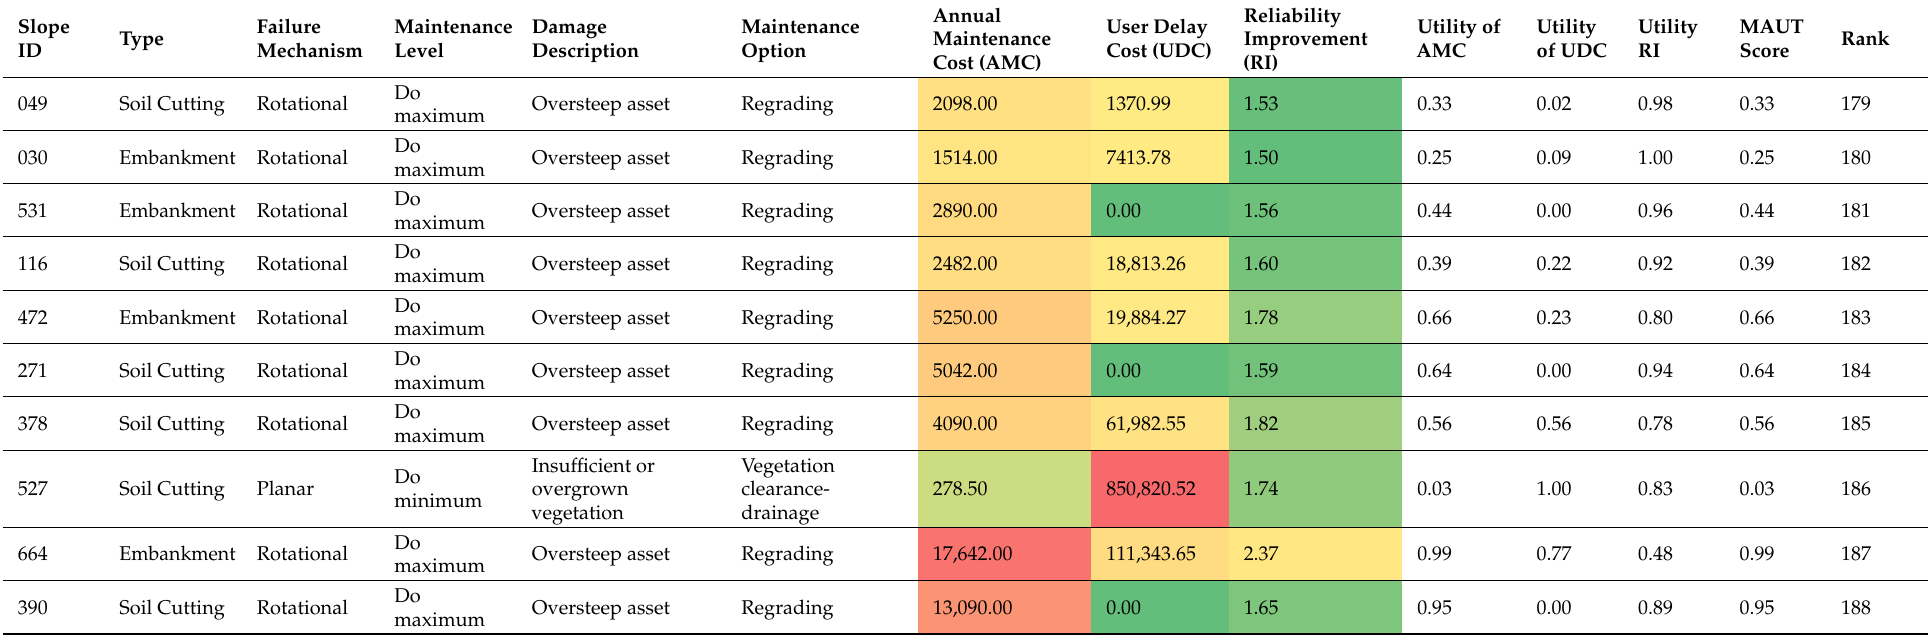
Table 5. Lowest ranked slopes using